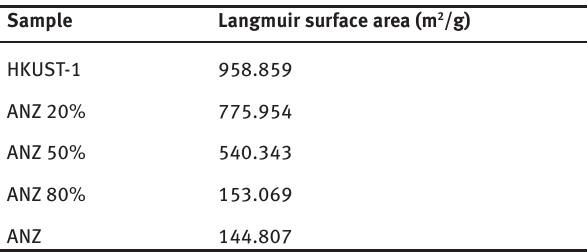
Table 2: Surface area analysis of composite ANZ@HKUST-1.